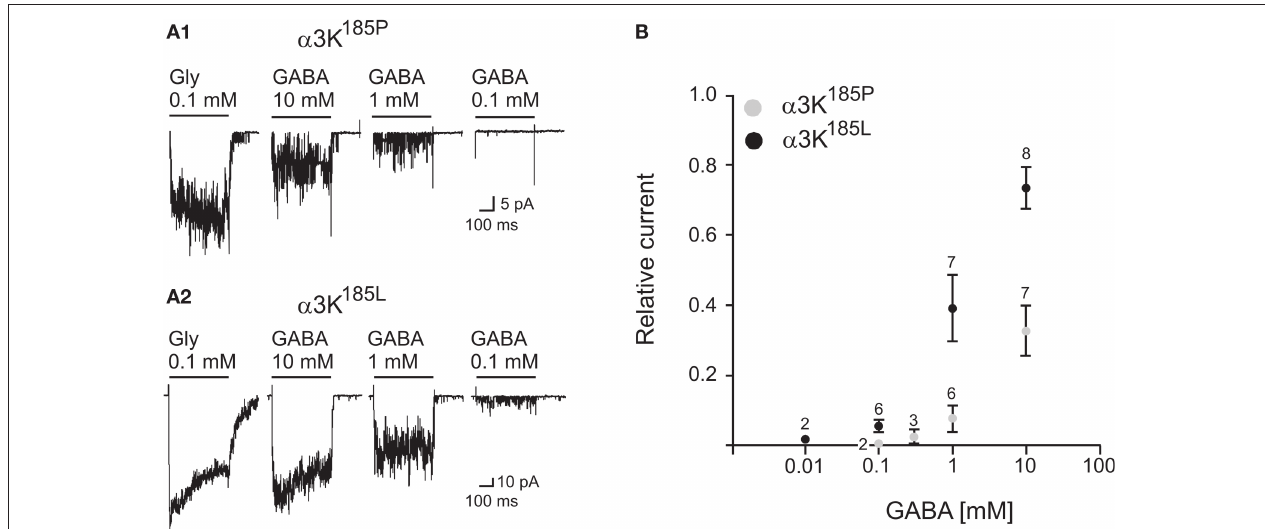
FIGURE 4 | Activation of GlyR α 3K 185P and GlyR α 3K 185L by GABA applications. (A1) Example traces of outside-out currents evoked by activation of GlyR α 3K 185P in response to the application of glycine (0.1 mM) and various concentrations of GABA (Vh = − 50 mV; Filter 1 kHz). (A2) Example traces of outside-out currents evoked by activation of GlyR α 3K 185L in response to the application of glycine (0.1 mM) and various concentrations of GABA